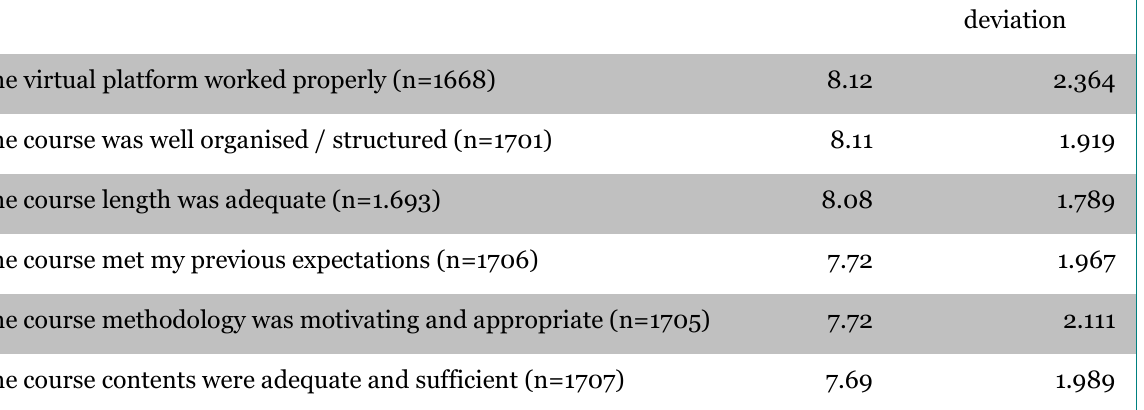
Evaluation of MOOC Elements in the Final Survey (from 1 to 10